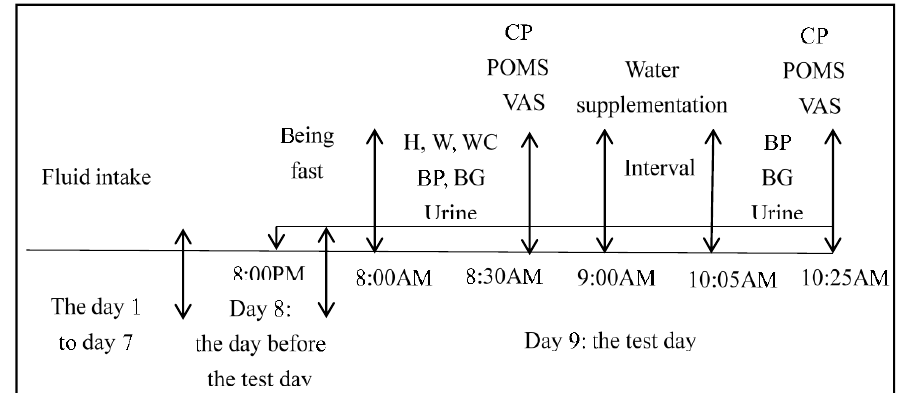
Figure 2. The study procedure. Note: H (Height); W (Weight); WC (Waist circumference); BP (Blood pressure); BG (Blood glucose); CP (Cognitive performances); POMS (Profile of Mood States); VAS (Visual Analogue Scales).